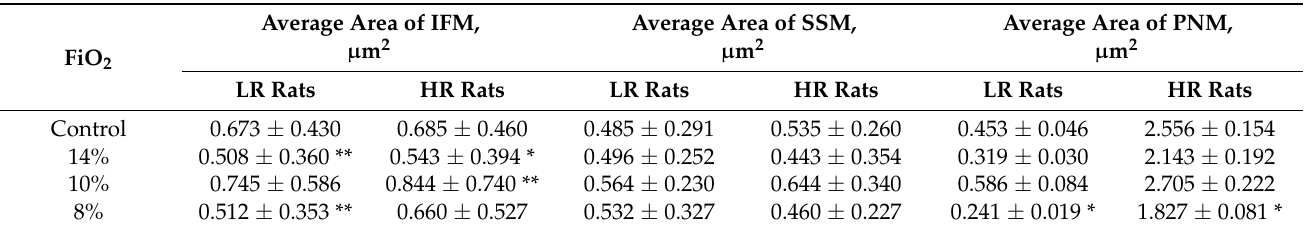
Table 2. Stereometric characteristics of IFM, SSM and PNM in the myocardium of HR and LR rats after a single exposure to different HBH regimens.